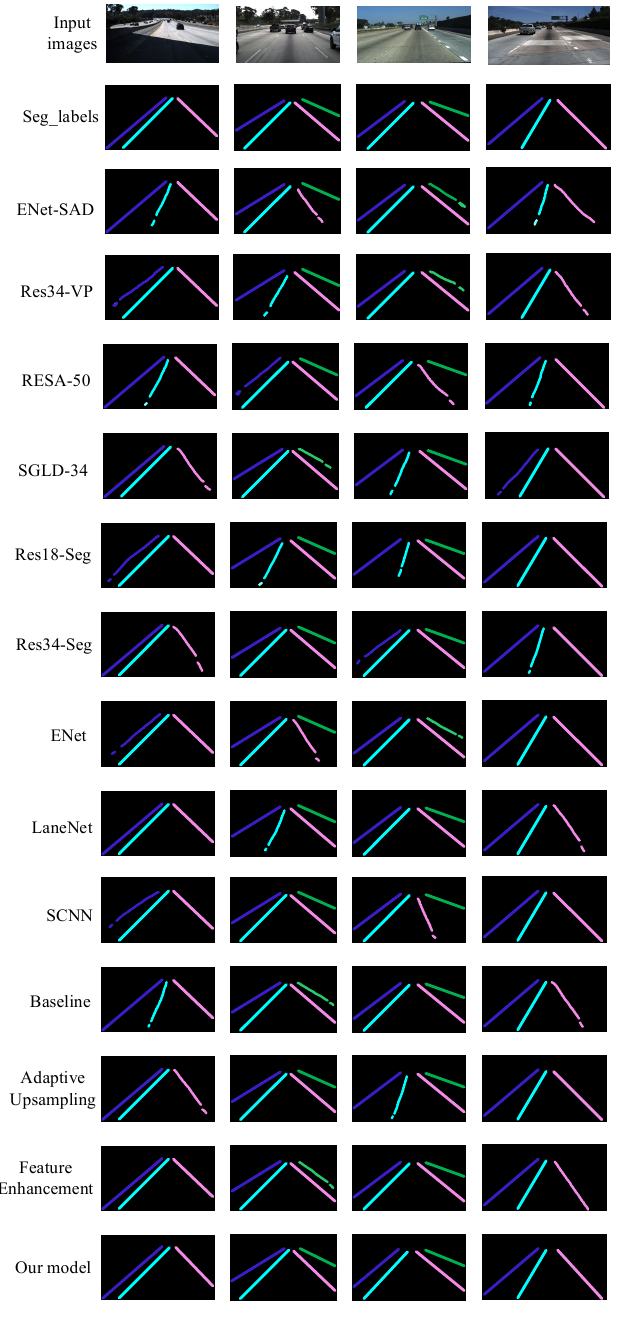
Figure 17. Instance Segmentation Analysis of Different Network Performance Based on TuSimple